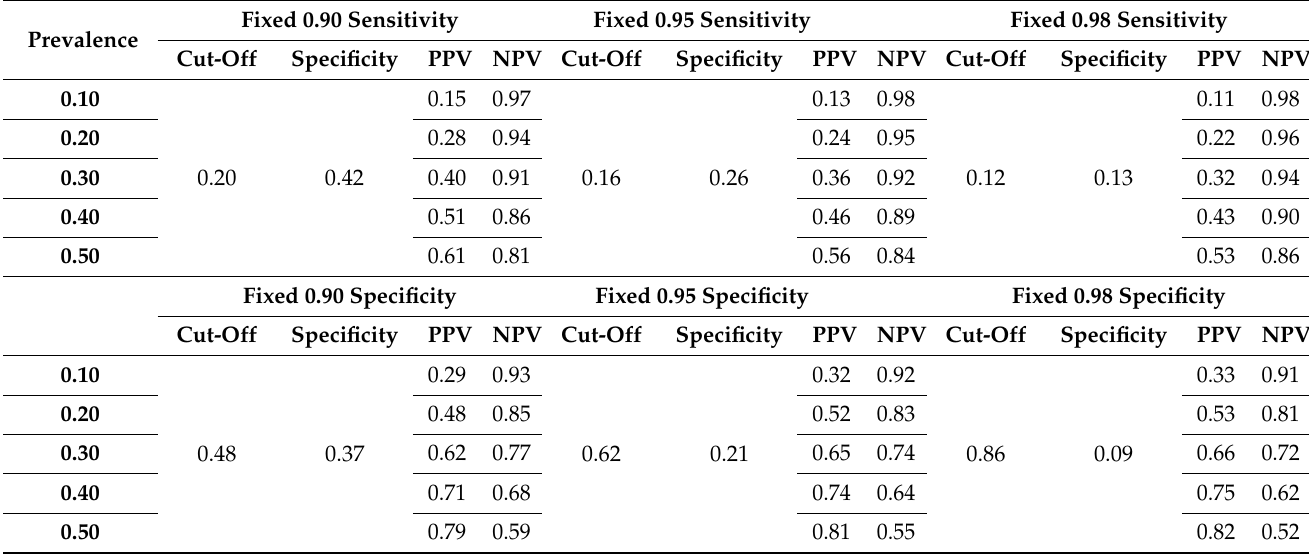
Table 2. Projected predictive values for different prevalences of advanced fibrosis at selected levels of sensitivity and selected levels of specificity. Fixed 0.90 Sensitivity Fixed 0.95 Sensitivity Fixed 0.98 Sensitivity Prevalence Cut-Off Specificity PPV NPV Cut-Off Specificity PPV NPV Cut-Off Specificity PPV NPV 0.10 0.98